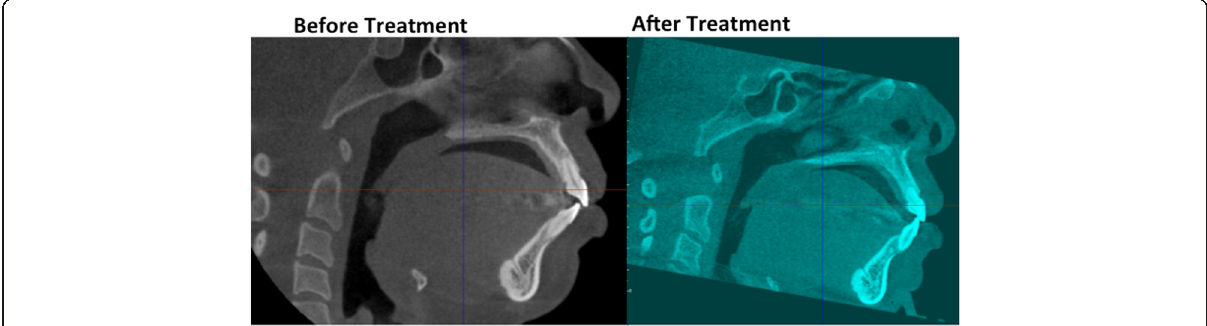
Fig. 7 Pretreatment ( black and white ) and posttreatment ( blue ) CBCT images of a high-angle patient. Note that the central incisor has been pushed past the buccal cortical plate after orthodontic